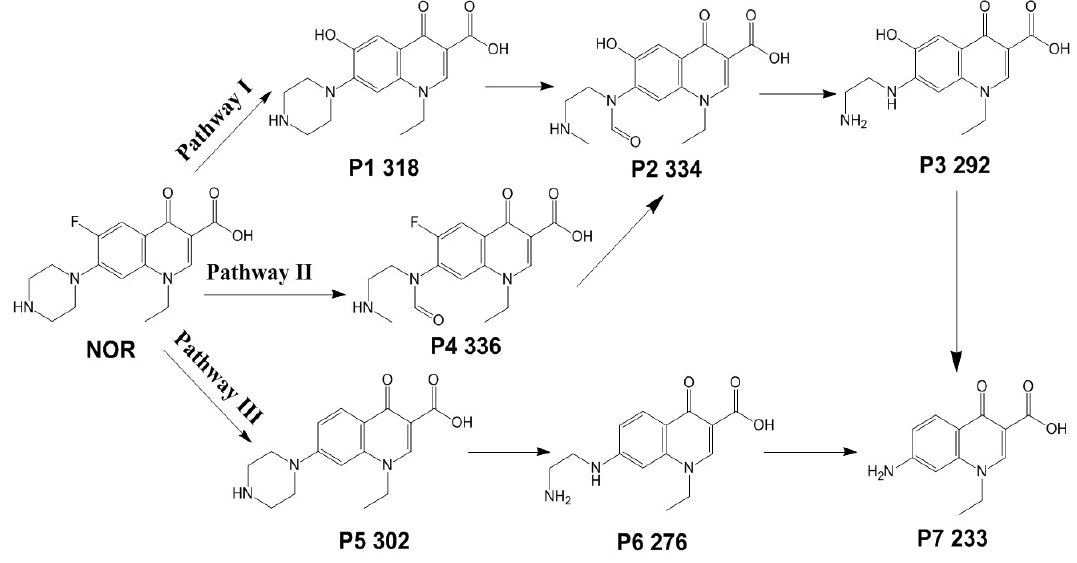
Figure 9. The MS spectra of NOR intermediates detected in sample withdrawn after 30 min of MW/UV reaction.